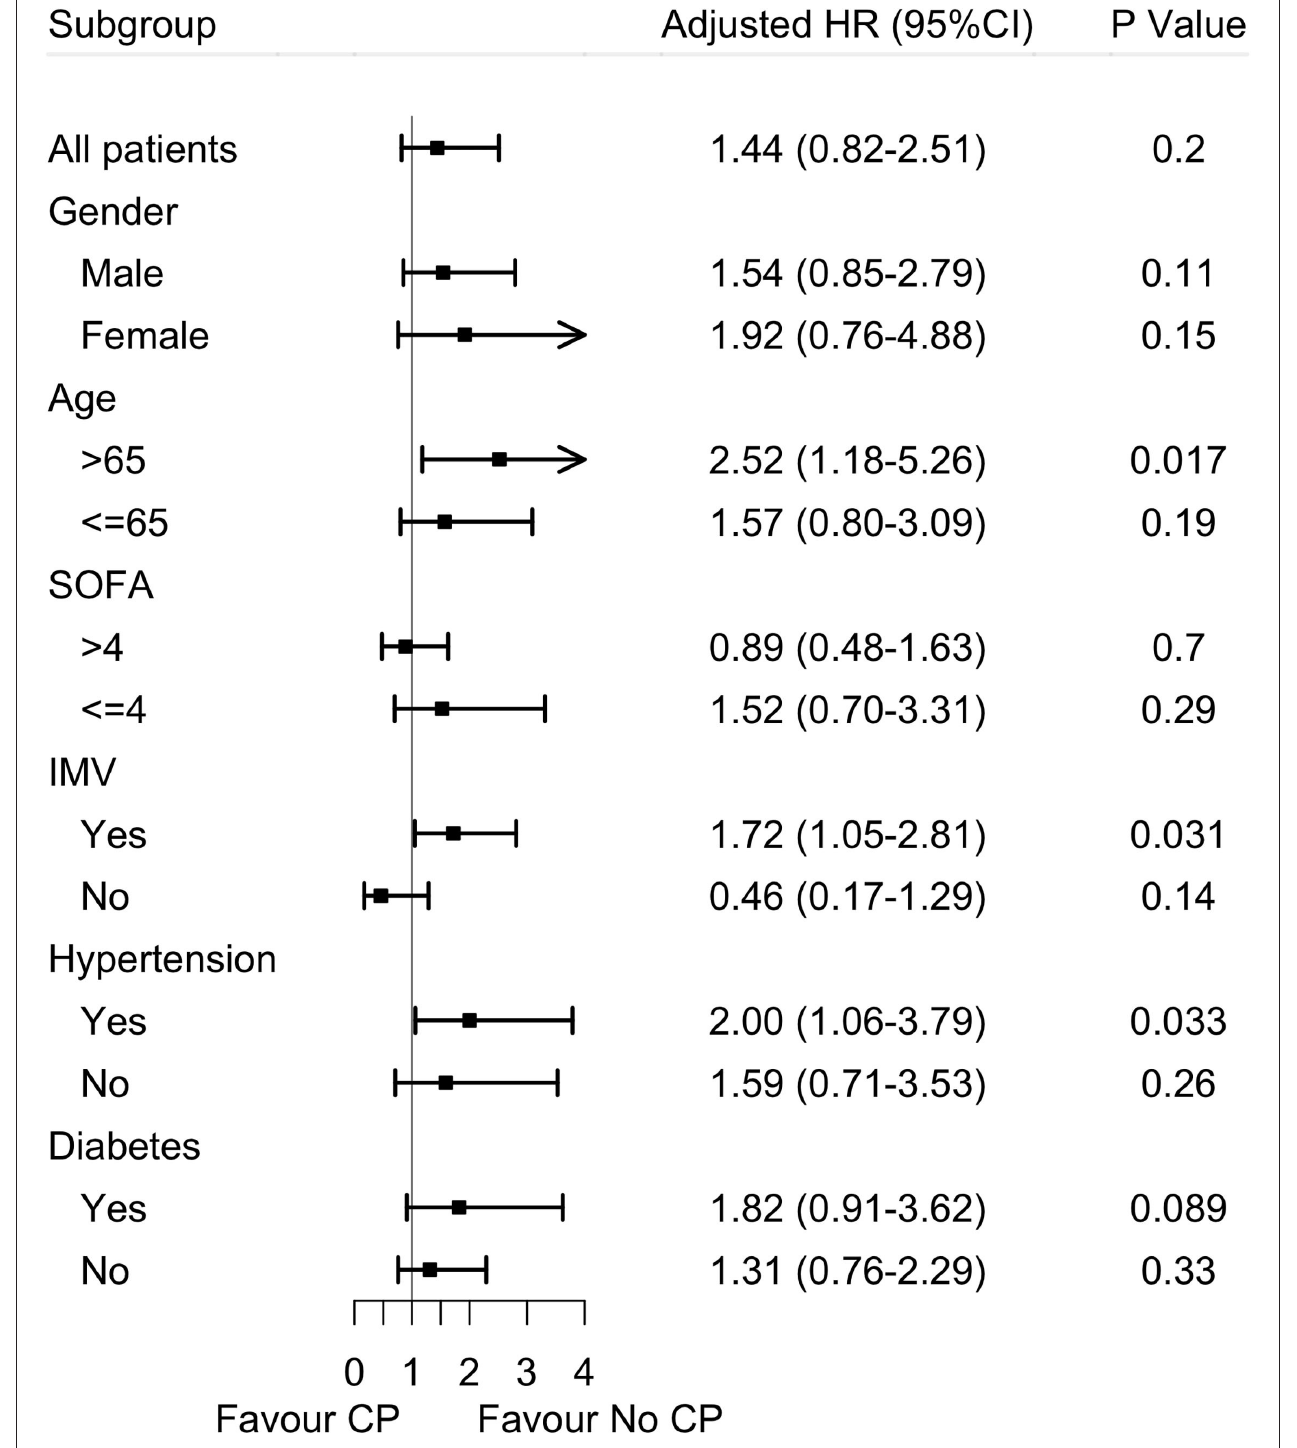
FIGURE 2 | Effects of convalescent plasma therapy on 60-day mortality according to subgroups in severe and life-threatening coronavirus disease 2019 (COVID-19). SOFA score, sequential organ failure assessment scores; IMV, invasive mechanical ventilation; CP, convalescent plasma therapy.